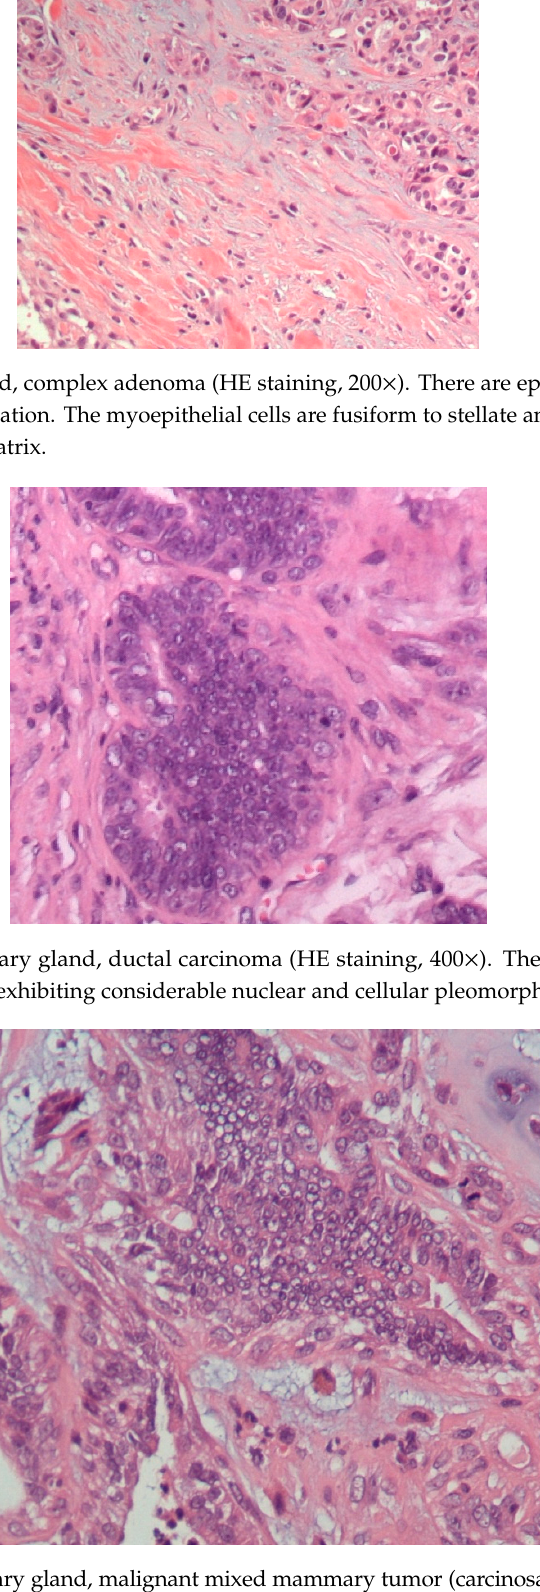
Figure 3. Canine mammary gland, malignant mixed mammary tumor (carcinosarcoma) (HE staining, 400×). Two neoplastic populations are present. There are neoplastic cells showing chondroid differentiation (chondrosarcoma). There is considerable nuclear and cellular pleomorphism of the epithelial cells.